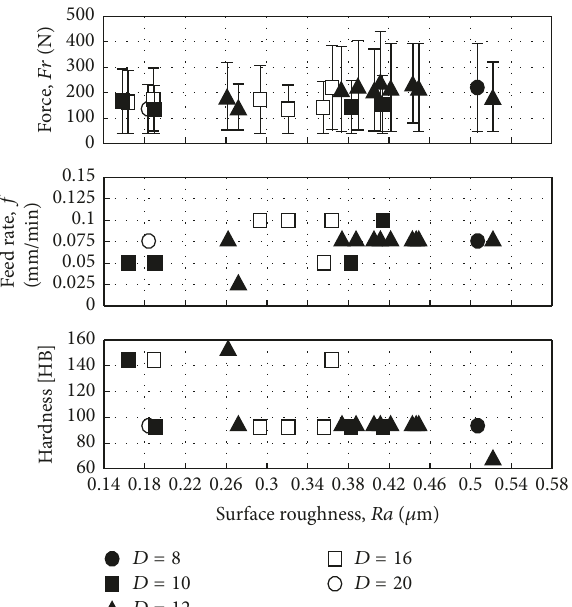
Figure 6: Relationship between the plane force, feed rate, and hardness with surface roughness for different diameters.